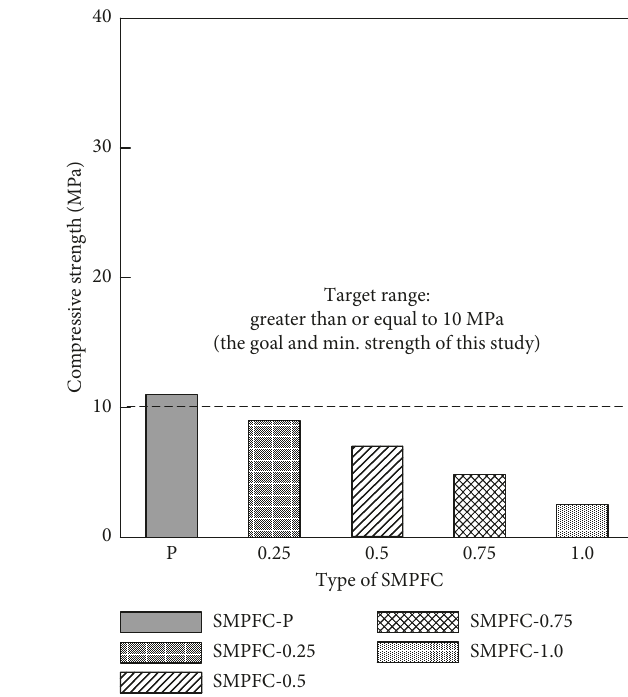
Figure 4: Test results of compressive strength (1D).